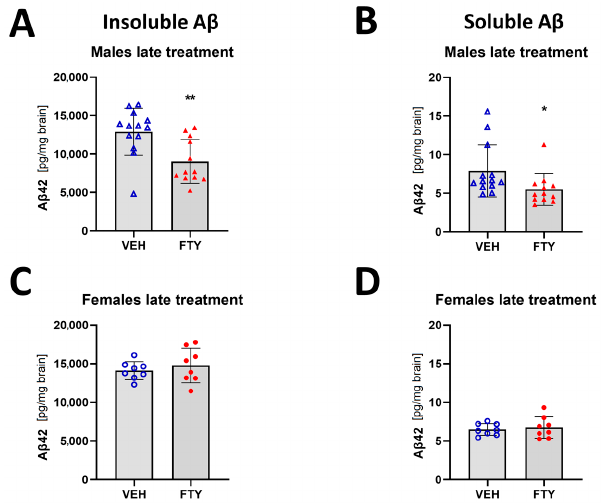
Figure 2. Quantification of insoluble ( A , C ) and soluble ( B , D ) A β 42 for late treated males ( A , B ) and females ( C , D ) APPtg mice. Data are presented as mean ± SD; n = 8 (except for males VEH, n = 13; FTY, n = 12). Significance was calculated using Wilcoxon–Mann–Whitney test, and it is given as *: p ≤ 0.05, **: p ≤ 0.01.